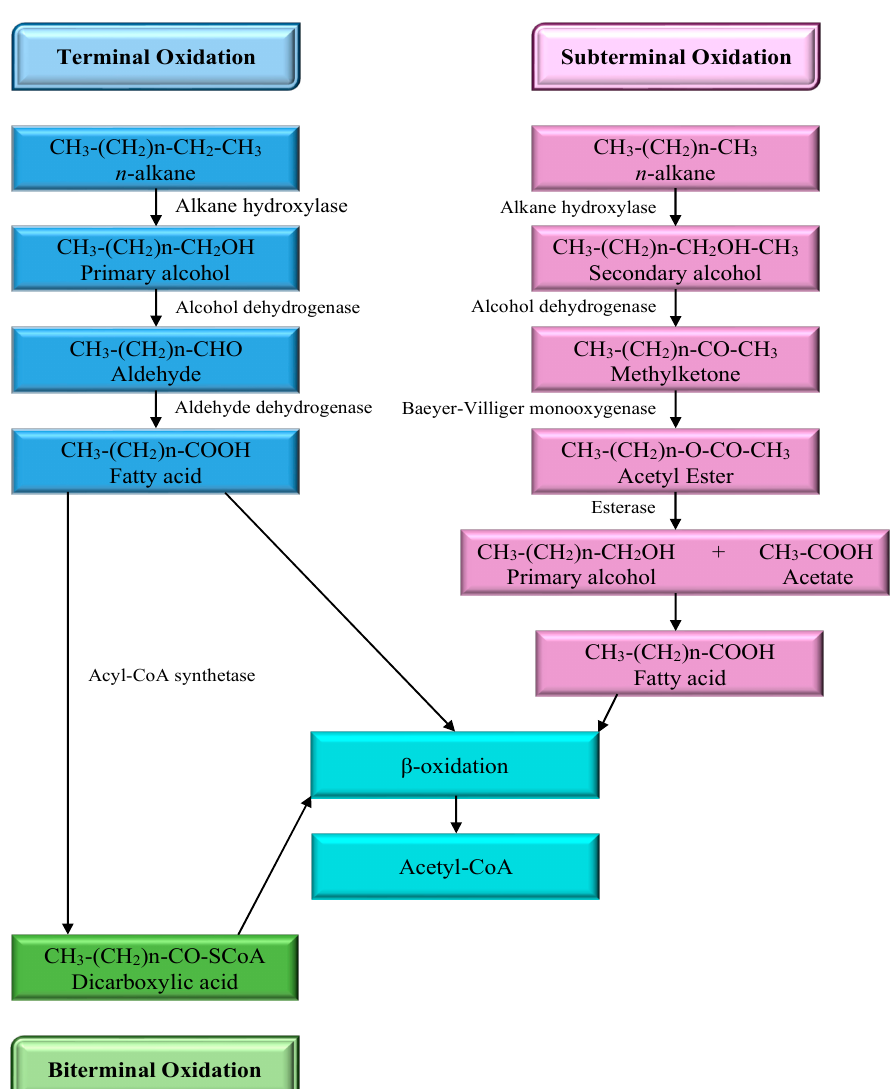
Figure 4. The summary of three degradation pathways of n -alkanes.